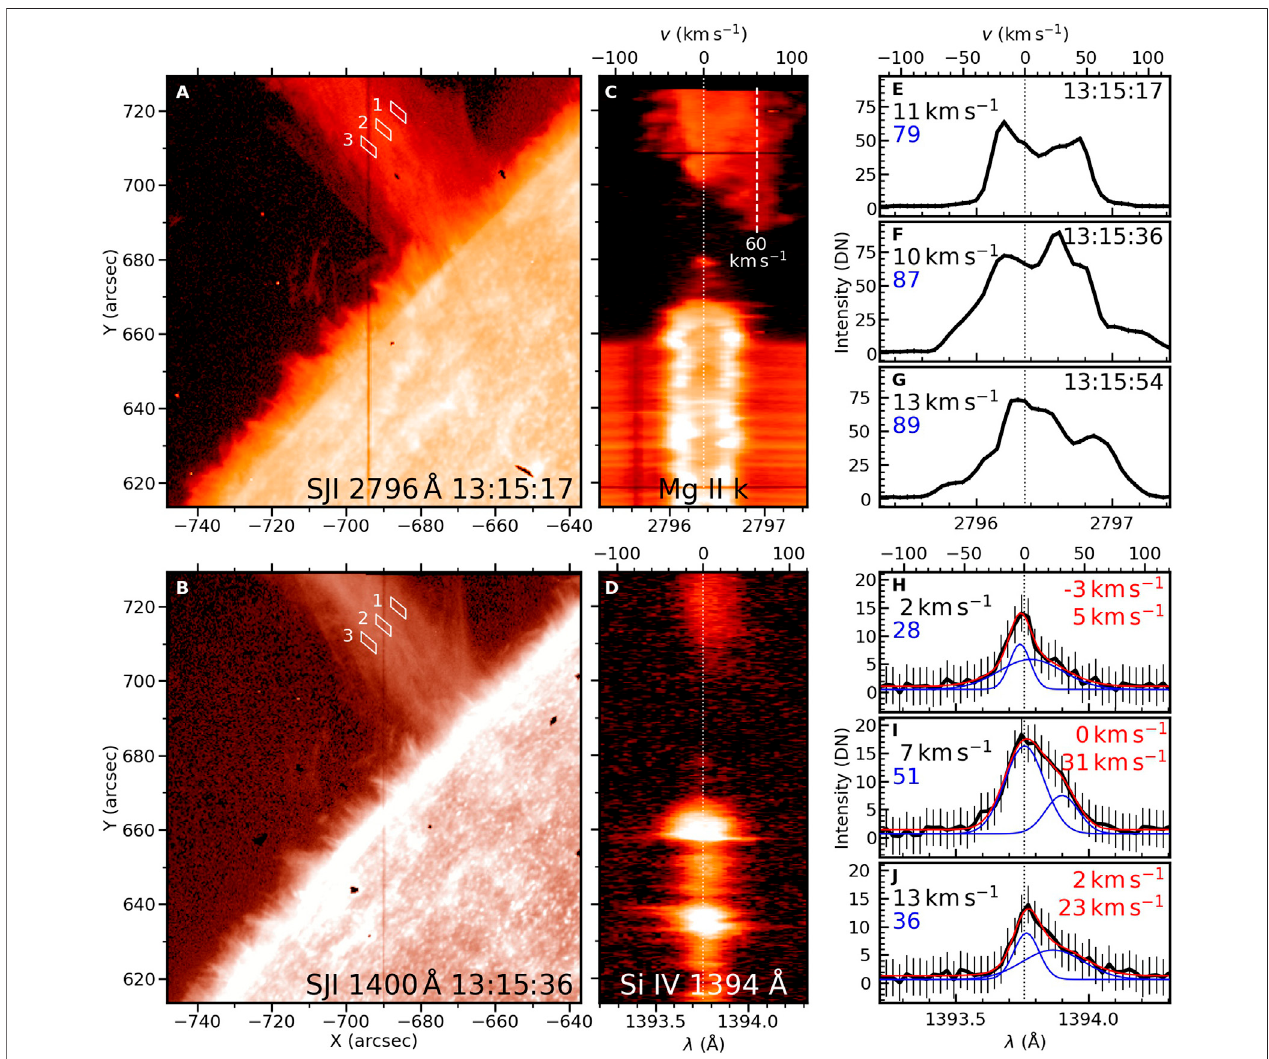
FIGURE4| Spectralobservationsaround13:15UT.Thelayoutissimilarto Figure3 butdoubleGaussian fi ttingisusedforSi IV 1394 (cid:1) Alinepro fi lesinpanels (H – J) , where blue curves show separate Gaussian components.